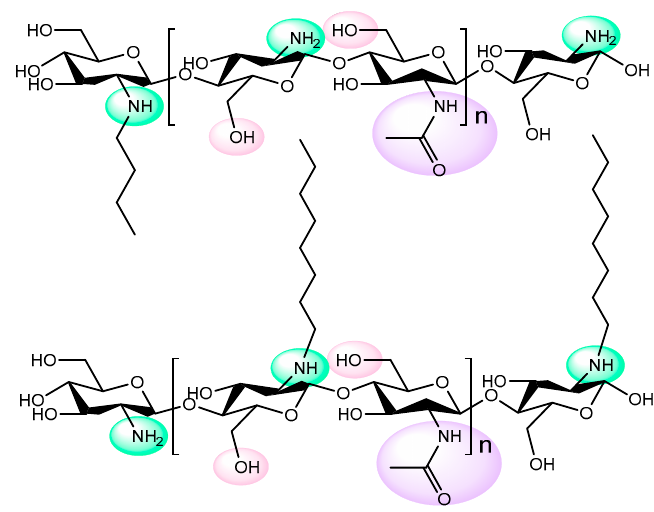
Figure 10. Schematic representation of chitosan activated with different alkyl chains.